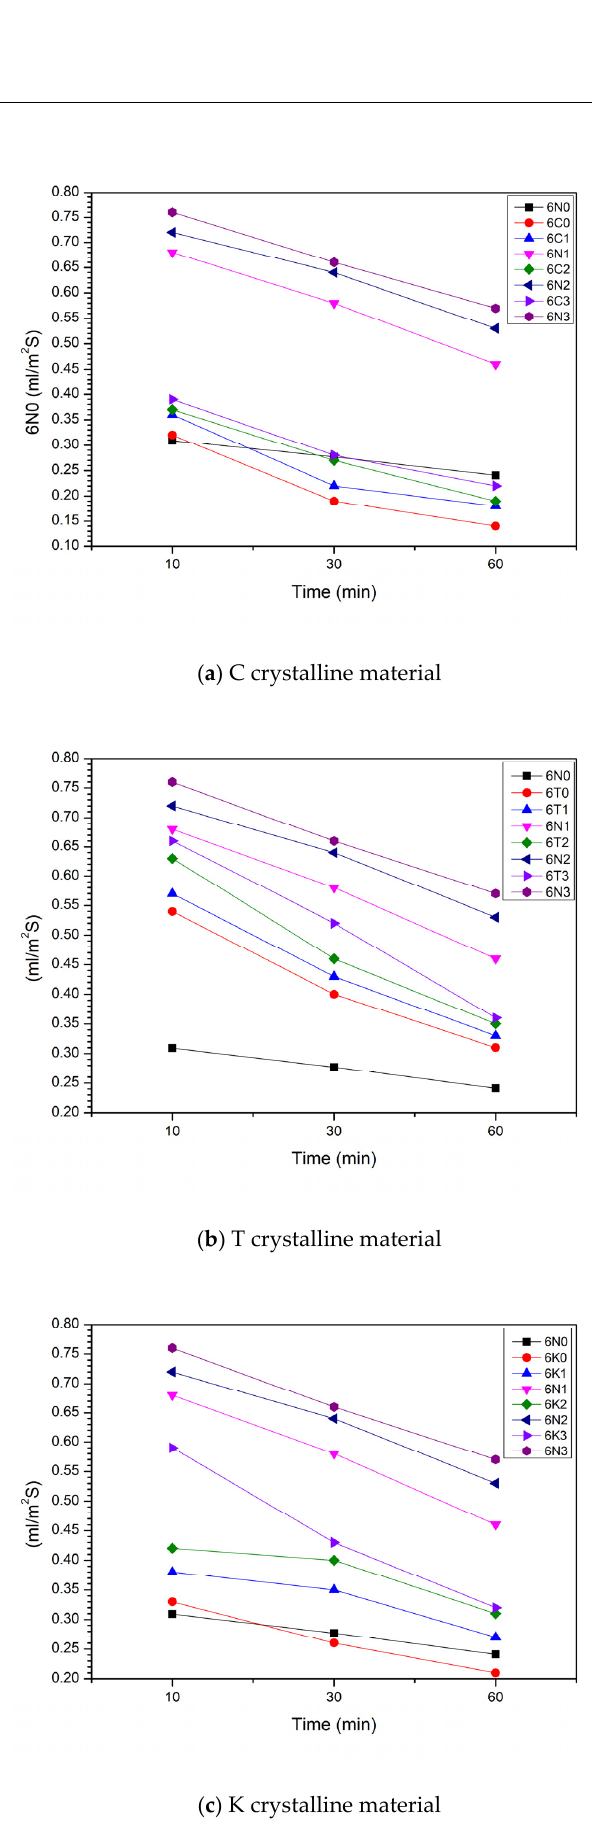
Figure 7. Initial surface water absorption of cement mortar after 7 days when W/C = 0.6.